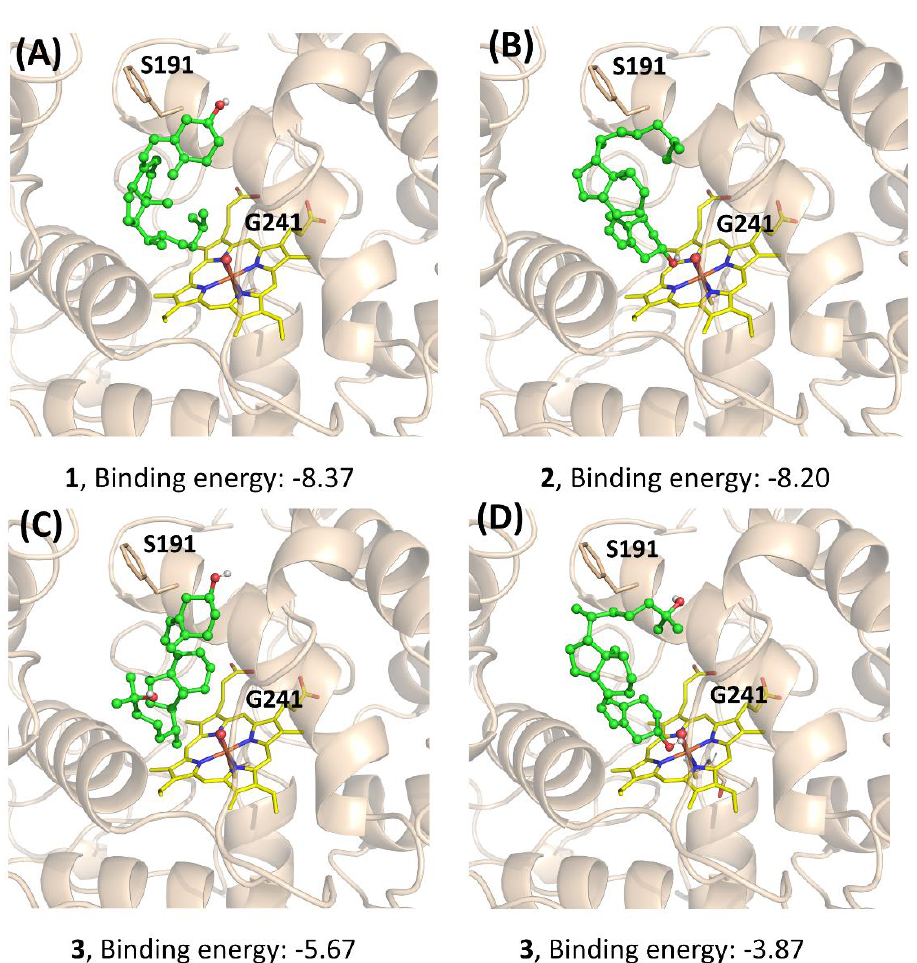
Figure 6. Docking study for the mechanistic insight on the performance of Aae UPO (Pada − I) for calcitriol synthesis. The poses of 1 ( A ), 2 ( B ), and 3 ( C , D ) with Fe=O center are demonstrated, respectively. Key residues (S191 and G241) interacting with the substrates are highlighted. Graphs were generated by PyMOL [33].